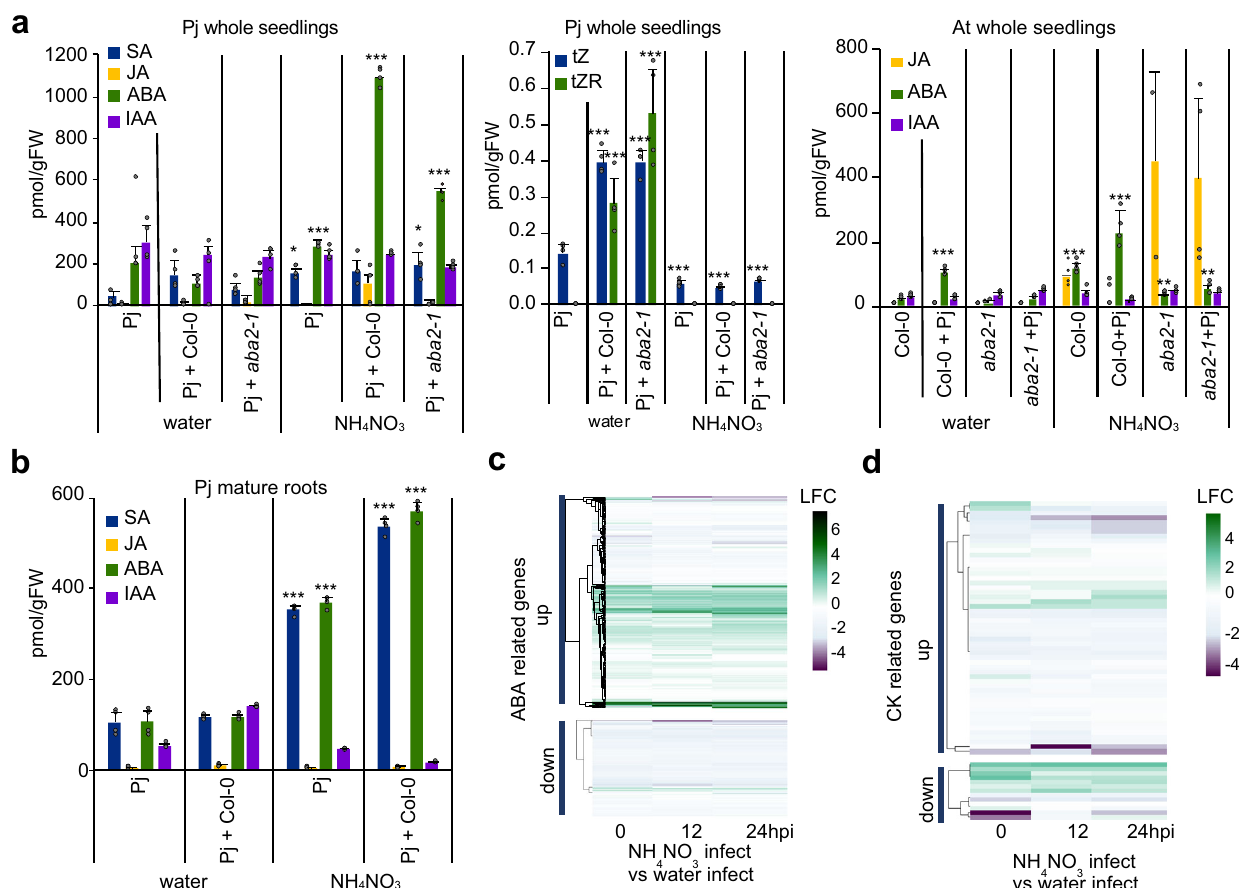
Fig. 5 ABA levels increase during nitrogen treatment. a Hormonal quanti fi cation of salicylic acid (SA), jasmonic acid (JA), abscisic acid (ABA), indole acetic acid (IAA), trans-zeatin (tZ) and trans-zeatin riboside (tZR) in P. japonicum whole seedlings and Arabidopsis (Col-0, aba2-1 ) whole seedlings treated with 10.3 mM NH 4 NO 3 (mean ± SD, n = 4 plants per treatment, 4 replicates). b Hormonal quanti fi cation of SA, JA, ABA, and IAA in P. japonicum mature roots treated with 10.3 mM NH 4 NO 3 (mean ± SD, n = 4 roots per treatment, 4 replicates). c Heatmap of the log2 fold change of 629 genes homologous to Arabidopsis ABA responsive genes (up or downregulated) for three time points in the NH 4 NO 3 infected vs the water infected RNAseq dataset in P. japonicum . d Heatmap of the log2 fold change of 67 genes homologous to Arabidopsis cytokinin responsive genes (up or downregulated) for three time points in the NH 4 NO 3 infect vs the water infect RNAseq dataset in P. japonicum . a , b Comparisons to respective control samples. Asterisks represent * P < 0.05, ** P < 0.001, *** P < 0.0001, Student ’ s t test, two tailed. Source data